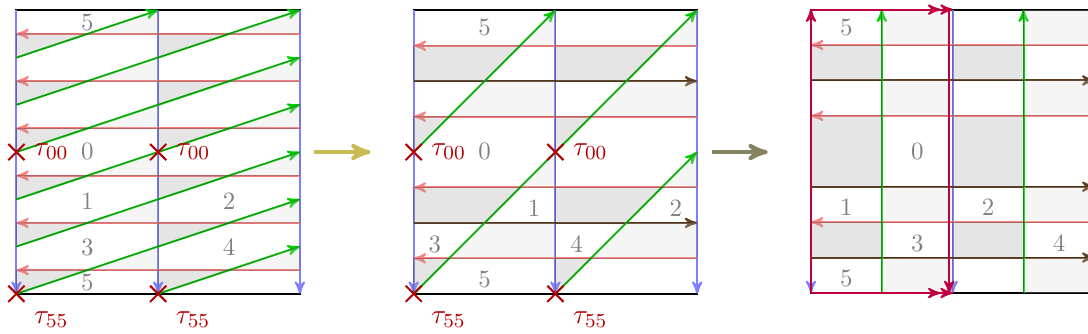
Figure 18. The chain of five-brane diagrams of family A connected by mass deformation for k = 3 : L 0 , 6 , 0 / Z 2 → L 2 , 4 , 2 / Z 2 → L 3 , 3 , 3 / Z 2 . It holds also with the orientifold projection, provided a Z 2 symmetry is preserved.